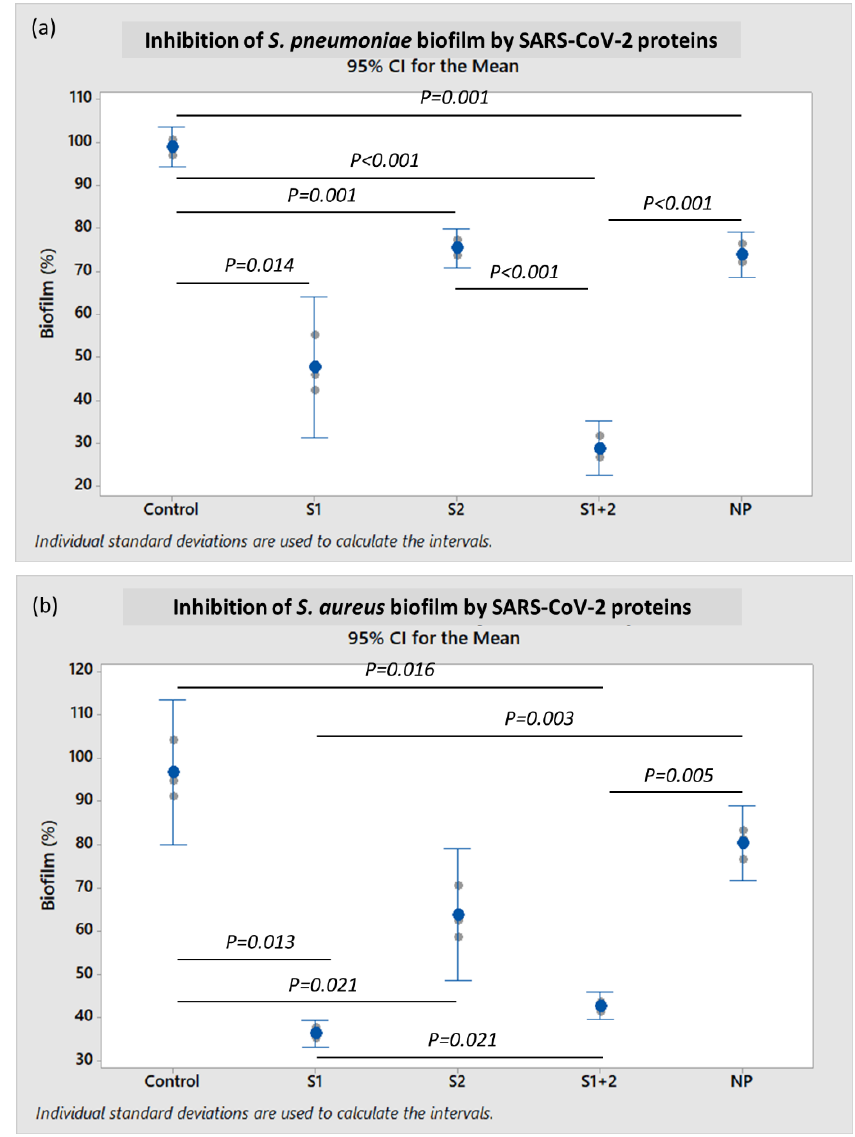
Figure 2. Characterization of biofilm production by ( a ) S. pneumoniae 19F and ( b ) S. aureus A10 strains, when co-incubated with recombinant SARS-CoV-2 spike S1 subunit, S2 ECD, S1 + S2 subunits, and nucleocapsid protein (NP) using the crystal violet assay. Each result was derived from three independent experiments or biological replicates (with each assay performed as technical triplicates). Each small gray datapoint represents the average or mean of technical triplicates, while each blue datapoint depicts the mean of three independent experiments. Intervals represent 95% CI for the mean. p -value < 0.05 was considered statistically significant by one-way ANOVA with Dunnett’s T3 post-hoc test.